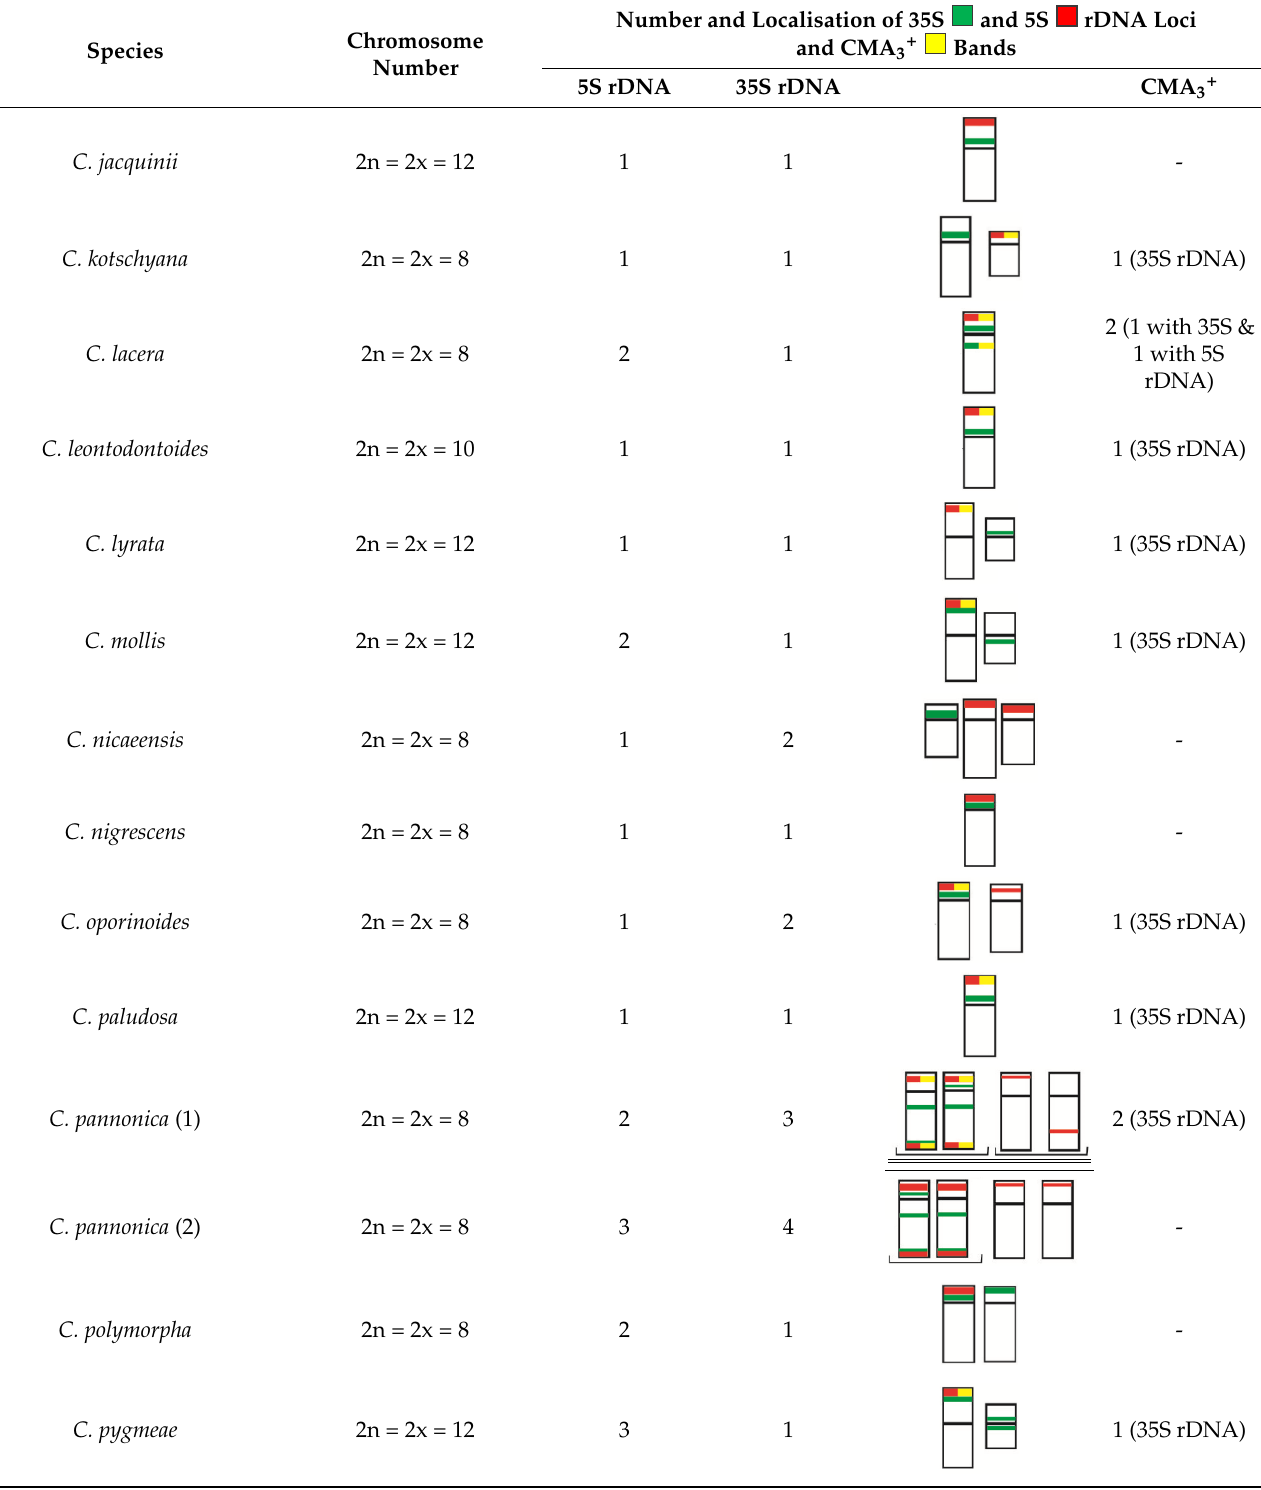
Table 1. Cont . Table 1. The number and localisation of the 35S and 5S rDNA loci and CMA 3+ bands in Crepis .